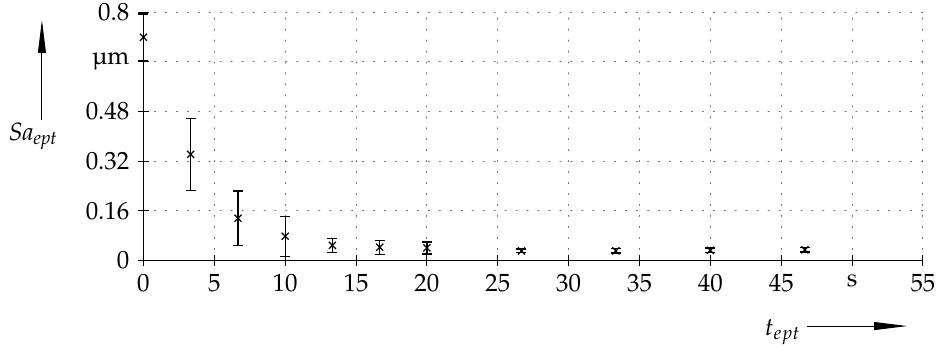
Figure 4. Mean average surface roughness Sa ept of the pipe inner surface dependent from t ept . The initial average surface roughness Sa 0 is located at the position t ept =